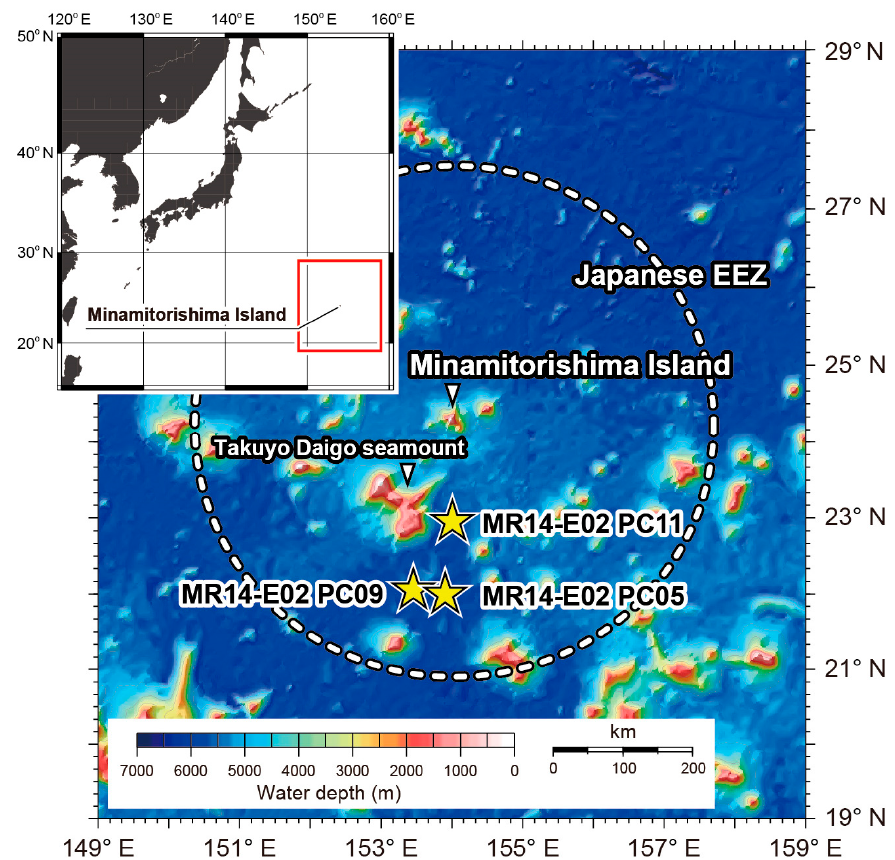
Figure 1. Locations of the study sites modified from [10] and [37].